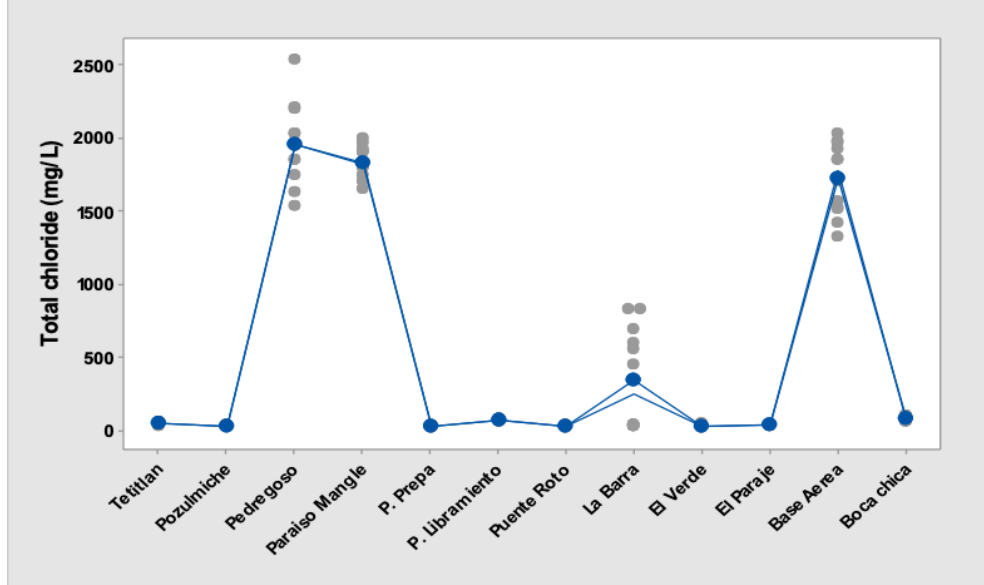
Figure 5. Chlorides values in each location; the grey points refer to the data dispersion in relation to the mean represented by the blue